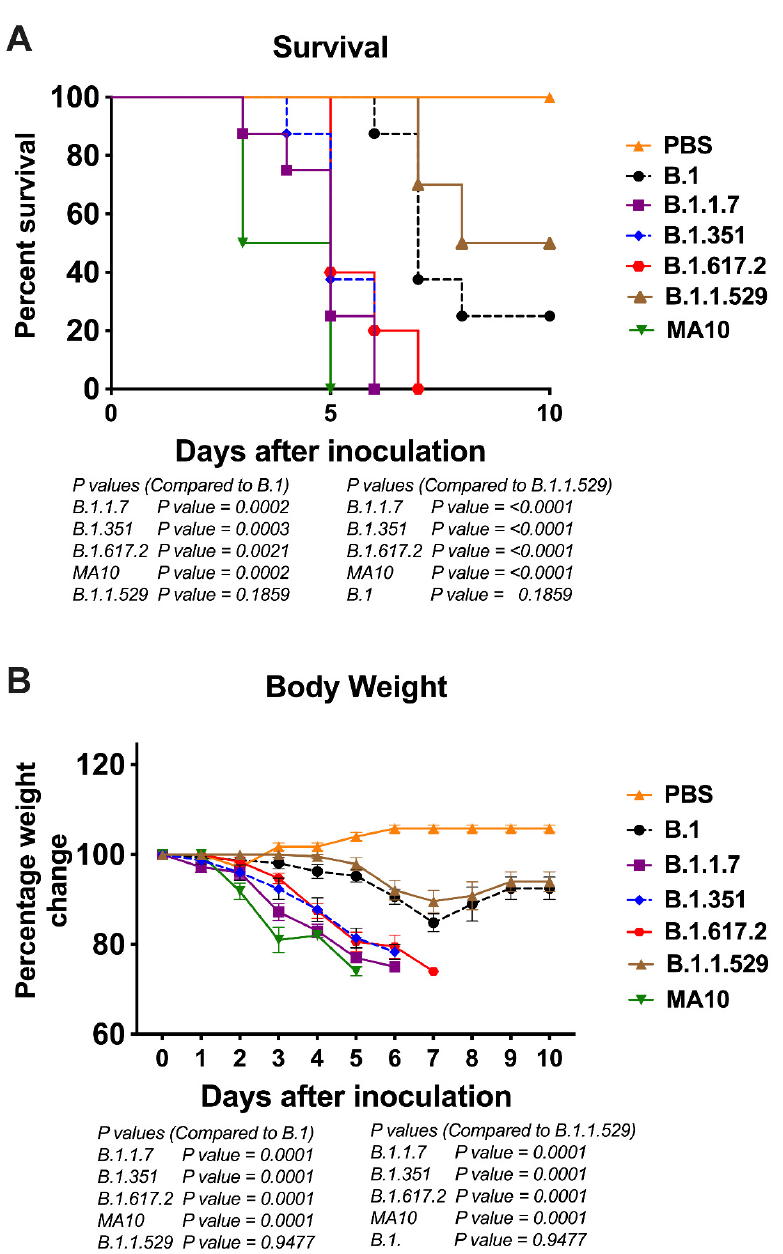
Figure 1. Analysis of survival and body weight in K18-hACE2 mice following infection with SARS- CoV-2 VoC. Eight-week-old K18-hACE2 mice were inoculated intranasally with PBS (mock) or 10 4 PFU of B.1 and individual variants ( n = 10–15 mice per group). ( A ) Survival curve. ( B ) Body weight change in percentage. Values are the mean ±